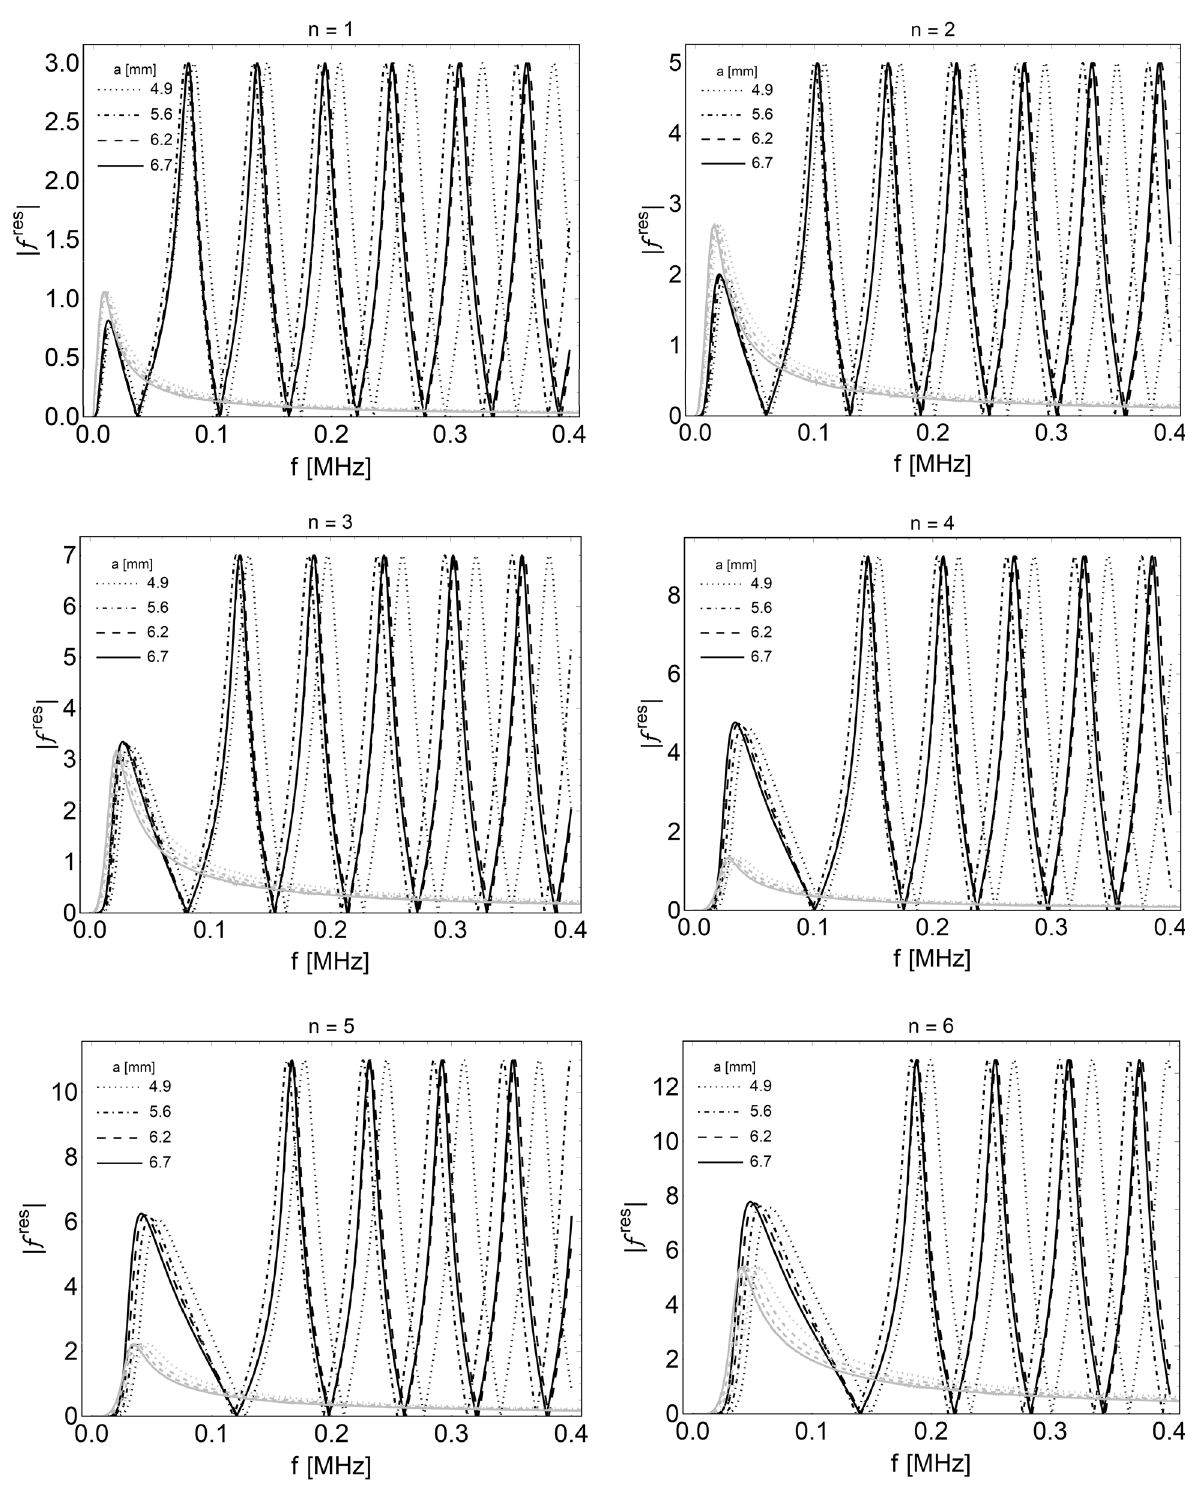
1 to n 6 , calculated at the different tumor sizes in = =